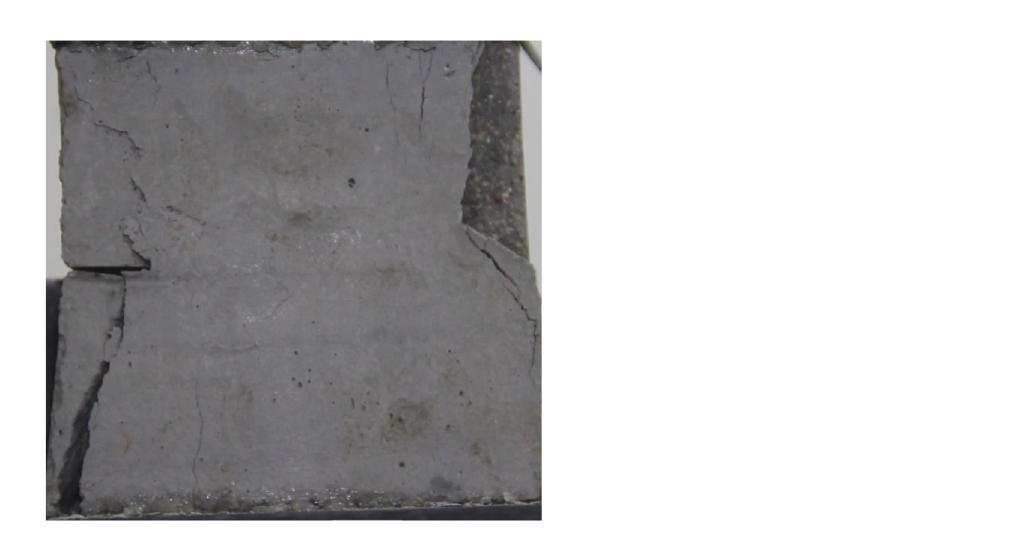
Figure 17. Photograph of a specimen showing tensile crack from the top surface caused by compression